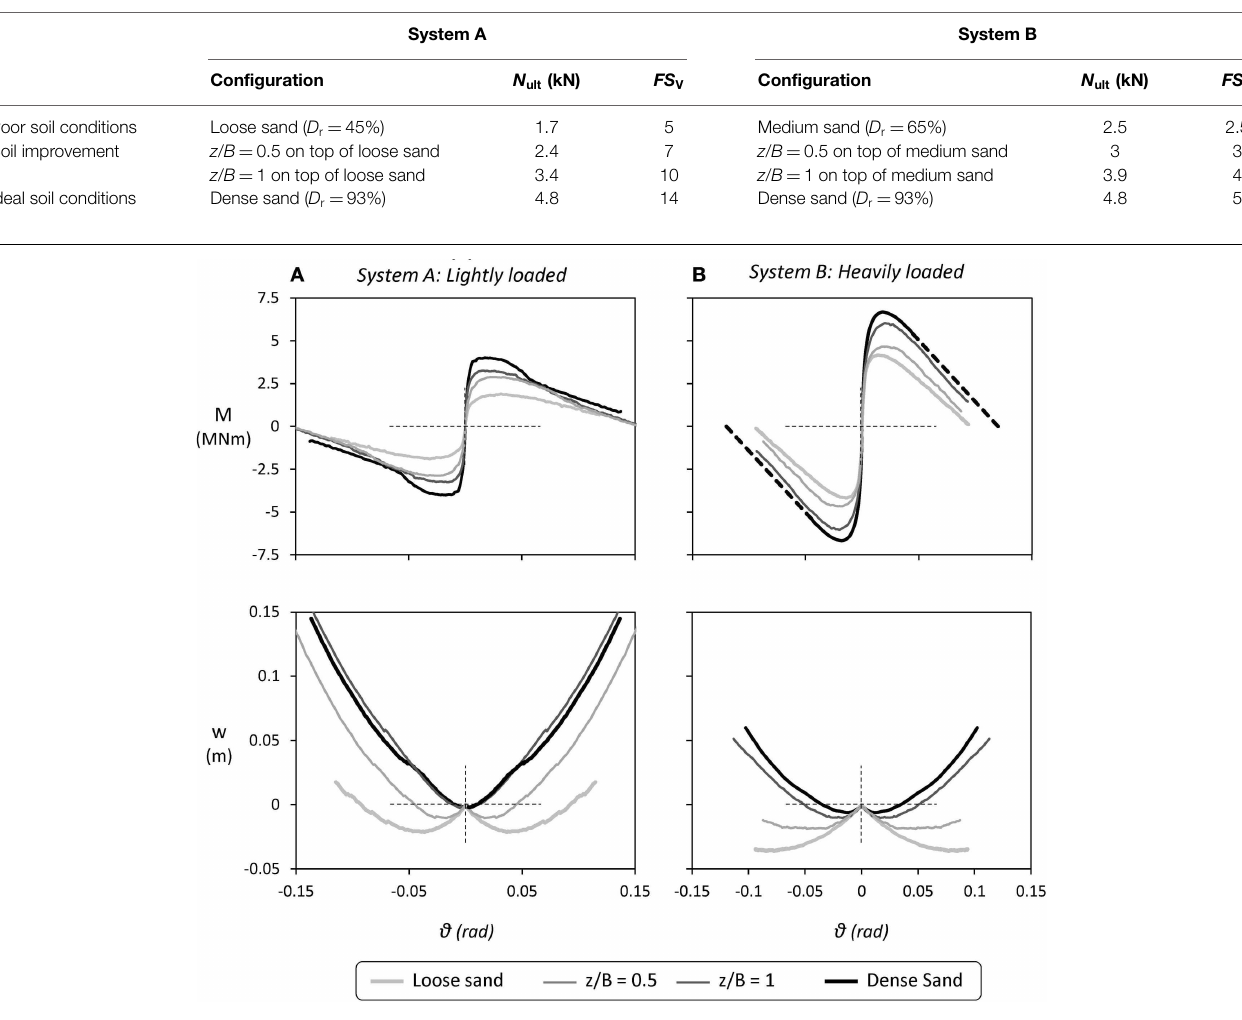
FIGURE 3 | Summary of monotonic pushover test results for the systems studied herein: moment–rotation (M– ϑ ) and settlement–rotation (w– ϑ ) response as a function of soil conditions for (A) the lightly loaded System A and (B) the heavily loaded System B